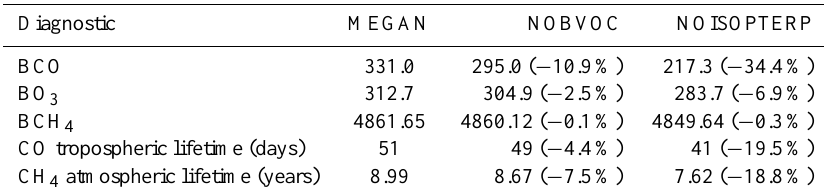
Fig. 4. The seasonal variability in surface O 3 sampled at EMEP monitoring stations during 2000. Comparisons are made against the ensemble mean from the TM5 simulations against monthly averages derived for a number of different countries, namely: Denmark, Poland, The Netherlands, Slovakia, Italy and Spain. The stations used for each country composite are provided in each separate panel. Table 3. The changes in the global tropospheric burdens and atmospheric lifetimes of O 3 , CO and CH 4 for the year 2000 due to the emission of C1-C3 BVOC species and isoprene/monoterpenes. The burdens are given in Tg species. The lifetime of tropospheric O 3 is equal to ∼ 24 days across all simulations. For CH 4 we assume a fixed soil sink of 30Tgyr − 1 . The percentage differences for the various diagnostics are given when compared with the MEGAN simulation, which applies all BVOC emissions. The troposphere is defined using the method defined in Stevenson et al. (2006). All burdens are given in Tg